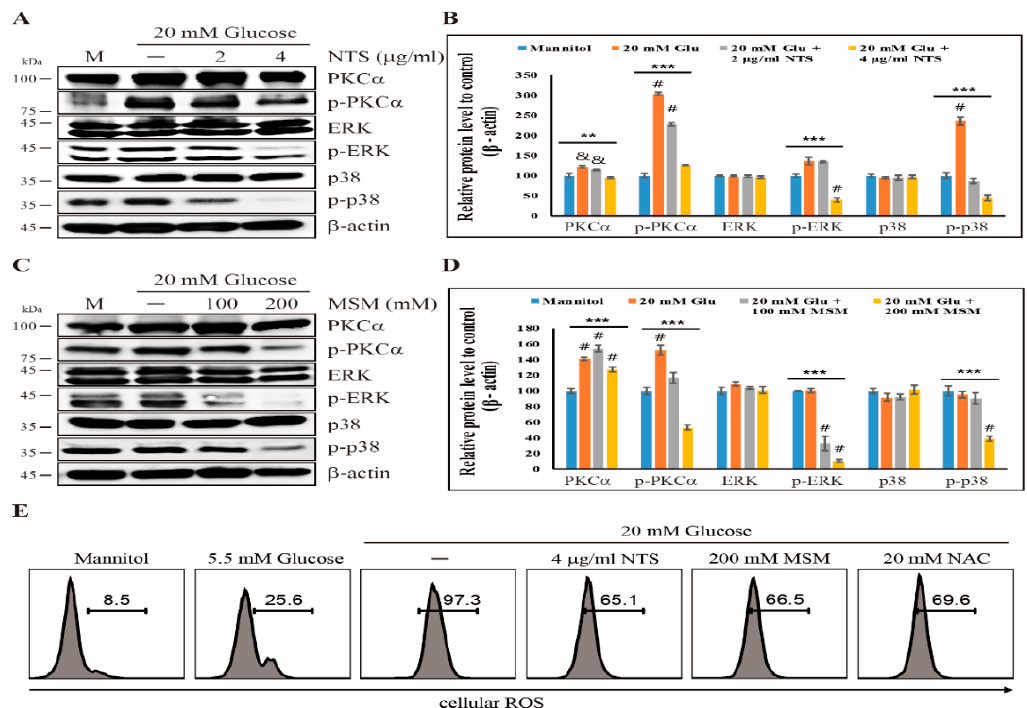
Figure 3. Sulfur compounds inhibit the PKC pathway. ( A ) Western blotting analysis of THP-1 cells treated with 2 and 4 μ g/mL NTS for 72 h showing the inhibition of high glucose-induced p-PKC α , p-ERK, and p-p38 expression. ( B ) The representative expression levels of proteins following NTS treatment were determined by densitometry and normalized to β -actin. The values are presented as means ± SEM of three independent experiments performed in duplicate ( n = 3). ** p < 0.01 and *** p < 0.001 ( ANOVA test). & The mean di ff erence is significant at the 0.01 level. # The mean di ff erence is significant at the 0.001 level. ( C ) The expression levels of high glucose-induced p-PKC α , p-ERK, and p-p38 proteins in THP-1 cells after treatment with MSM (100 and 200 mM) for 72 h were detected by western blotting. ( D ) The representative expression levels of proteins by MSM were determined by densitometry and normalized to β -actin. The values are presented as means ± SEM of three independent experiments performed in duplicate ( n = 3). *** p < 0.001 ( ANOVA test). # The mean di ff erence is significant at the 0.001 level. ( E ) Flow cytometry analysis showing the inhibition of the high glucose-induced ROS by 4 µ g / mL of NTS and 200 mM of MSM. 20 mM NAC (N-Acetyl- l -cysteine) was used as a positive control for antioxidant e ff ects of sulfur compounds.